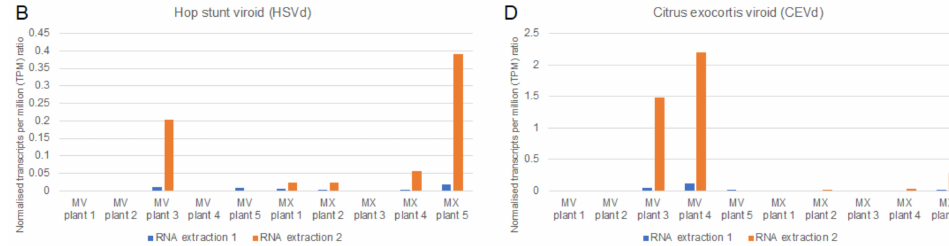
Figure 6. Clustered column chart displaying the relative pathogen concentration (normalized tran- scripts per million (TPM) ratio) at time point 3 (203 days post inoculation) for citrus tristeza virus (CTV) ( A ), Hop stunt viroid (HSVd) ( B ), citrus dwarfing viroid (CDVd) ( C ) and citrus exocortis viroid (CEVd) ( D ) obtained from RNA extracted with two different RNA extraction methods (RNA extrac- tion 1: CTAB with LiCl precipitation; RNA extraction 2: CTAB extraction with ethanol precipitation) from five plants per cultivar (MX: ‘Mexican Lime’; MV: ‘Madam